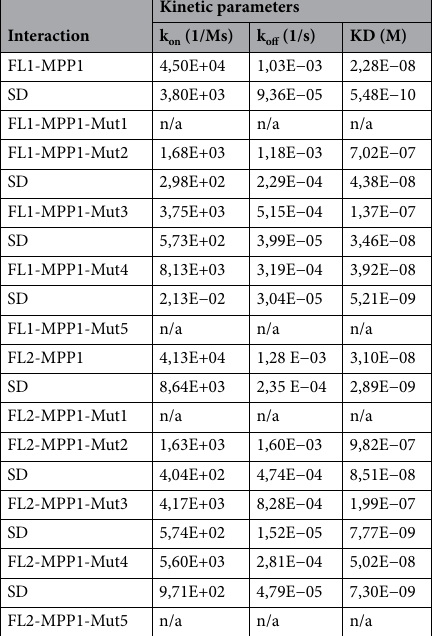
Table 1. Kinetic parameters for the interaction of full length recombinant MPP1 or its truncated mutants with flotillin 1 and 2. Obtained K D values are averages of 3 independent series of experiments presented in Figs. 2 and 5 and were found to be independent of ligand concentration (see Figure